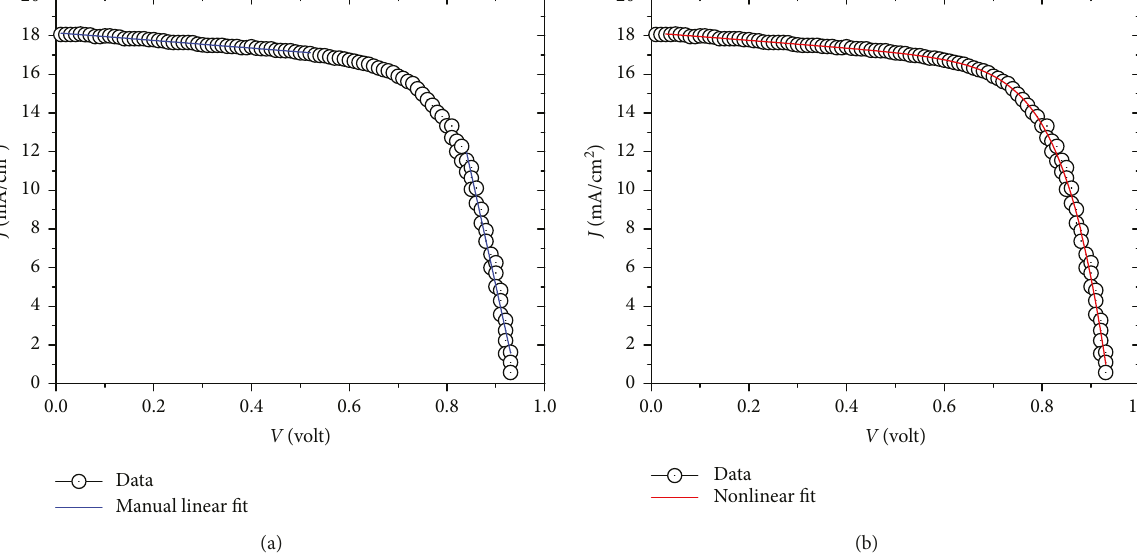
with CH NH PbI: (a) manual fi t and (b) nonlinear curve fi 2 3 3